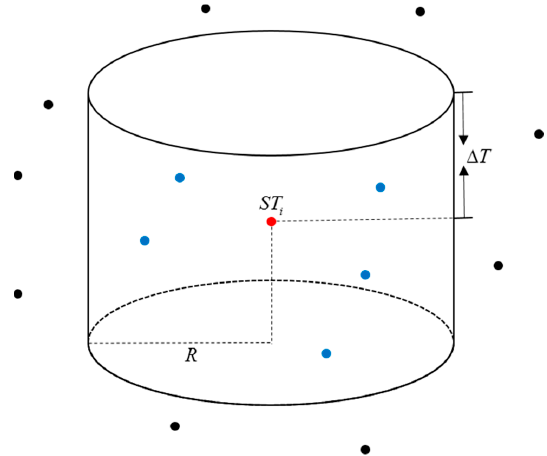
Figure 5. The spatial temporal neighboring region schematic diagram, after introducing time property. The space ‐ time neighboring region in this figure means two ‐ dimensional of space and one dimensional of time. The definition of the blue and red dots follows Figure 2.